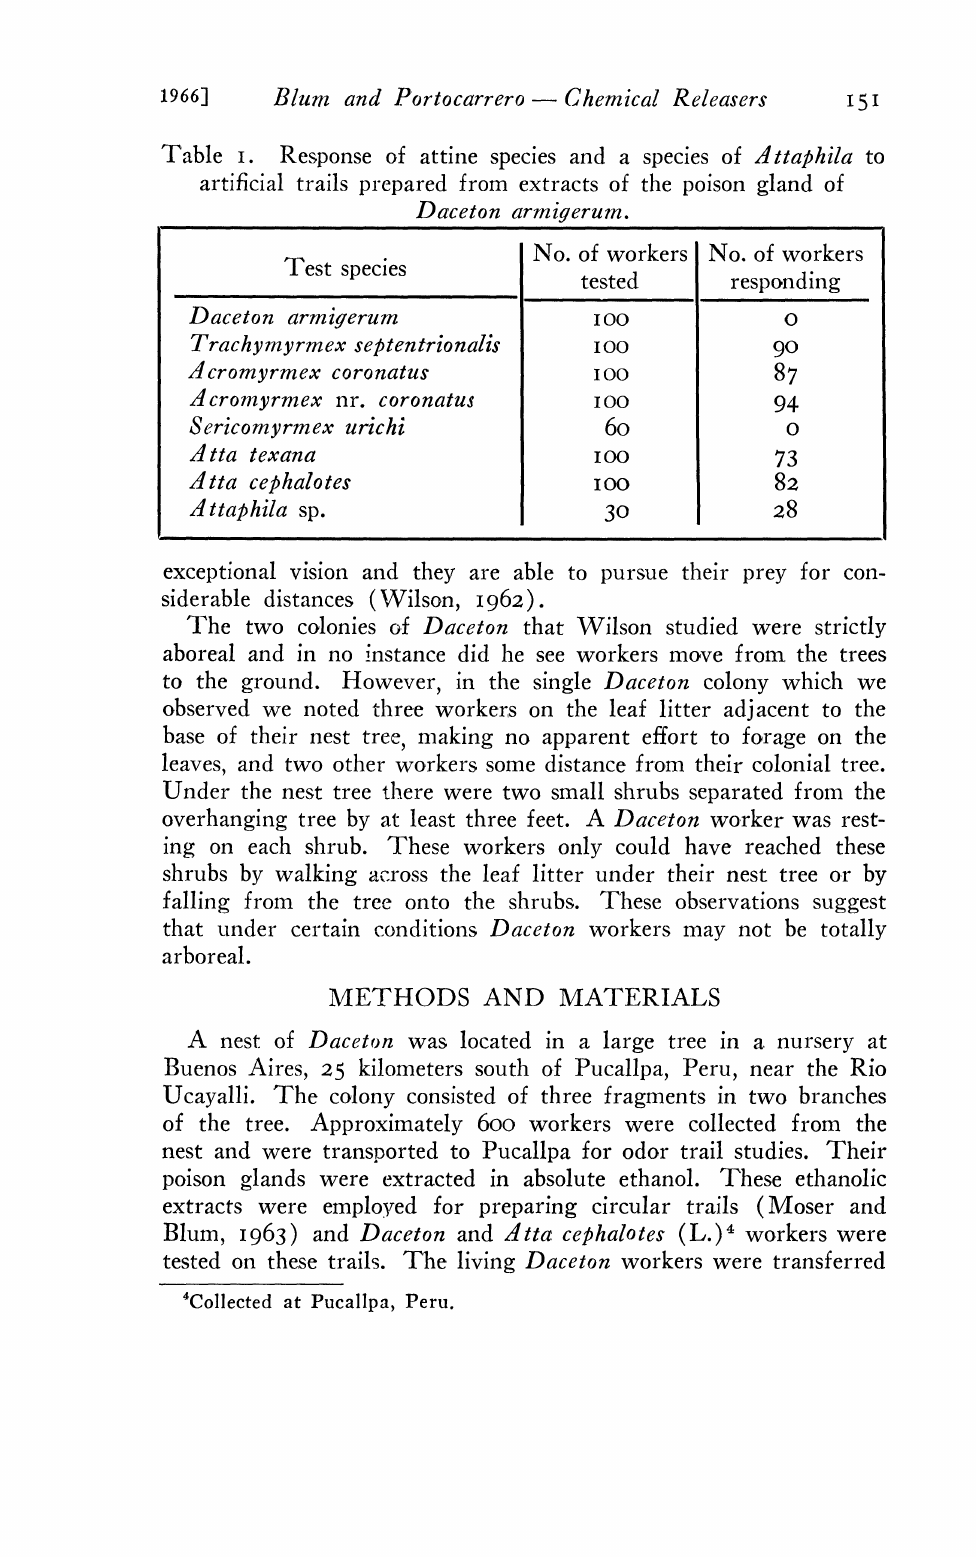
. Response of attine species and a species of A ttaphila to Table artificial trails prepared from extracts of the poison gland of Test